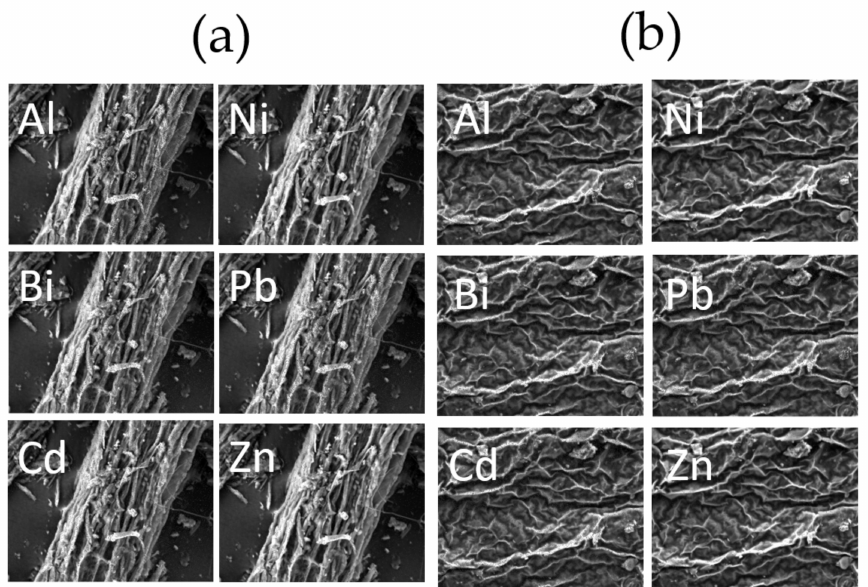
Figure 7. SEM and element mapping image of the ( a ) roots and ( b ) shoots in Taracum officinale. (EDDS at a concentration of 5 mmol kg − 1 ).